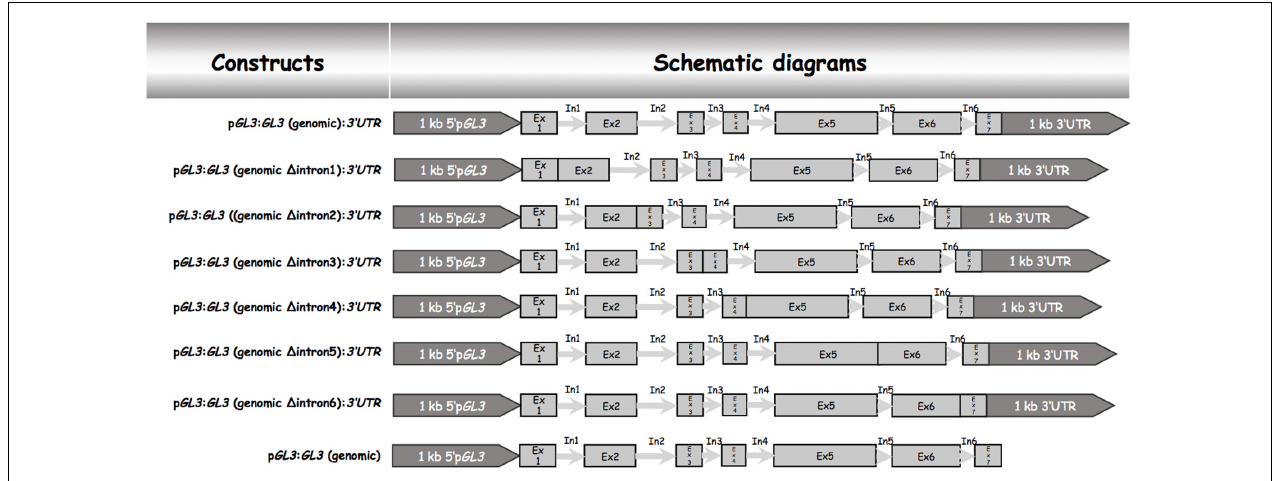
FIGURE 1 | Schematic description genomic GL3 constructs and intron deletions. All constructs were cloned into the pAMPAT vector backbone. The length of promoter, exon, and intron elements are proportional to the respective sequence length. Ex, exon; In,